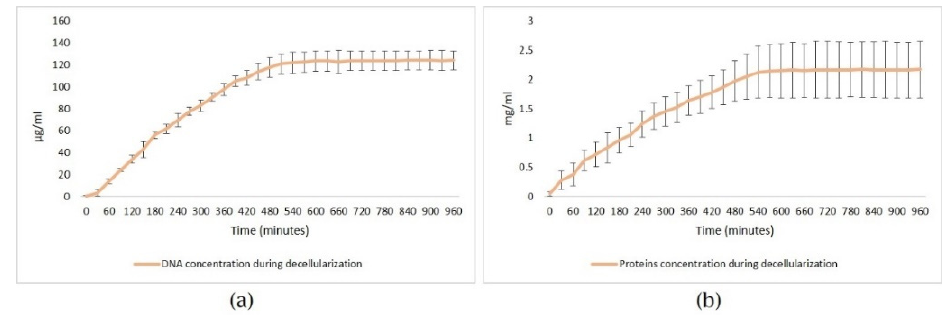
Figure 8 . The mean value from the 10 decellularization sessions of total ( a ) DNA and ( b ) proteins concentration measured in the decellularization solution. Both DNA and proteins concentration reached the plateau at around 540 min.